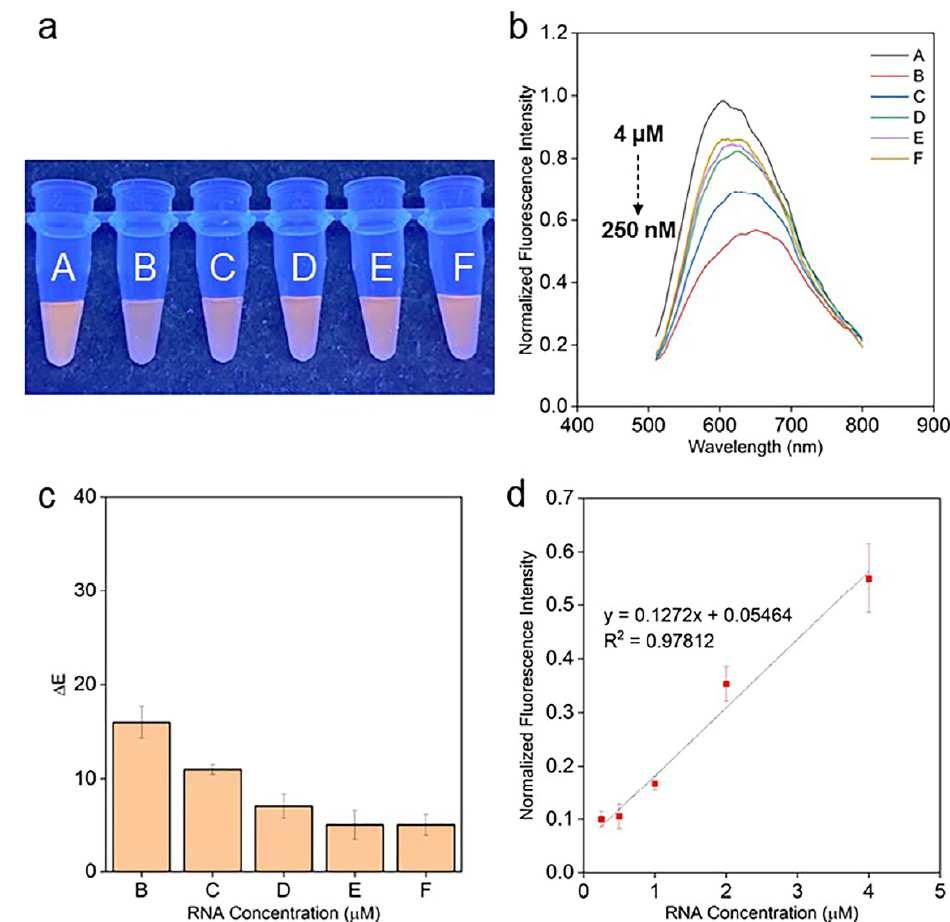
Figure 6. mir21 assay ( a – d ): ( a ) digital images of vials containing (A) PT-T20-PNA1-1 μ M mir21 (control), and (B–F) PT-T20 with 4 μ M, 2 μ M, 1 μ M, 500 nM and 250 nM mir21 and, ( b ) correspond- ing fluorescence spectra, ( c ) Δ E values calculated with respect to vial A and ( d ) linear plot of mir21 concentration versus normalized fluorescence intensity.